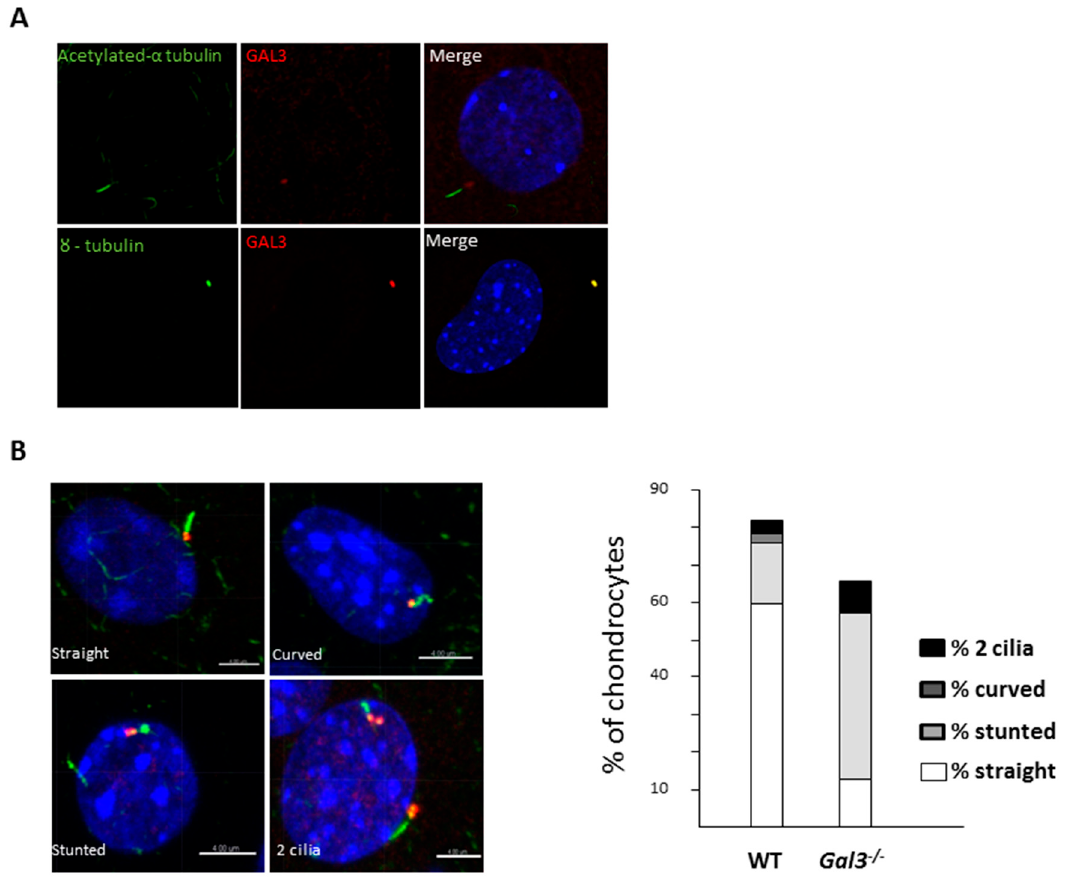
Figure 6. Deletion of galectin 3 ( Gal3 ) induces alteration of articular chondrocyte primary cilium. ( A ) Confocal microscopy of acetylated α -tubulin (green) and GAL3 (red) (top pictures) or γ -tubulin (green) and GAL3 (red) (bottom pictures) in primary cilium of cultured wild-type (WT) chondrocytes ( n = 5 independent experiments). ( B ) Various shapes of primary cilia were observed: straight, stunted, curved and double cilia. The relative proportions of each shape in WT versus Gal3 − / − cultures are indicated. n = 642 WT and n = 769 Gal3 − / − chondrocytes. Scale bars: 4 µm.